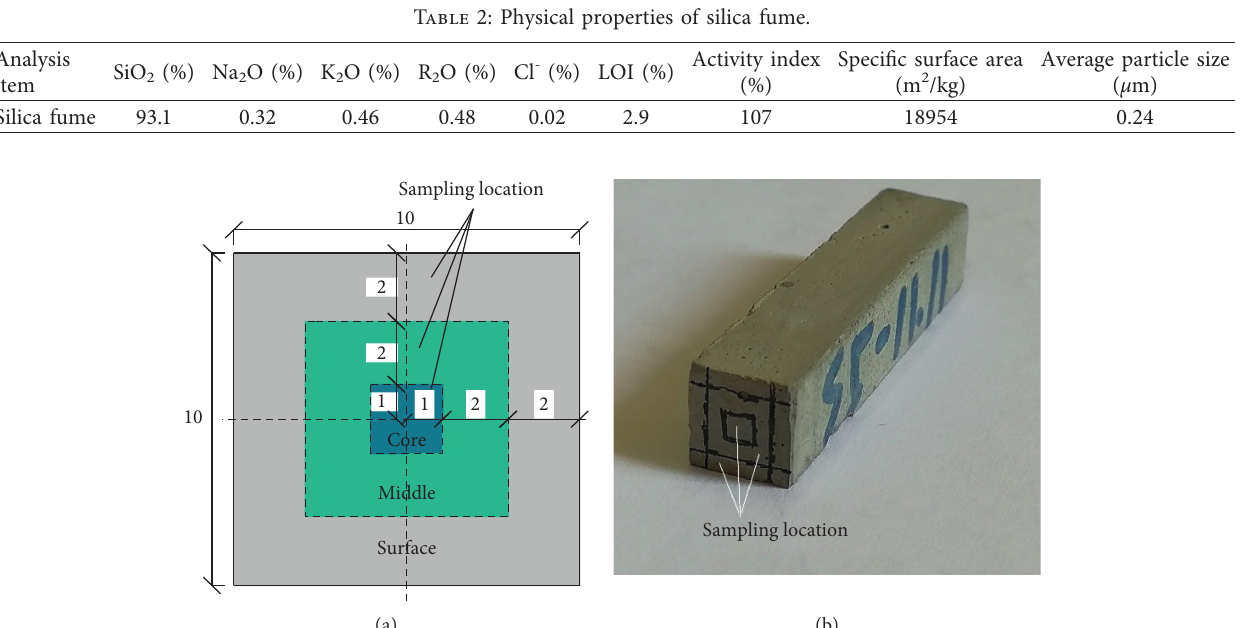
Figure 1: Diagram of sampling position of XRD sample: (a) sampling position of cross section (unit: mm); (b) sample of hardened cement paste and XRD sampling location.